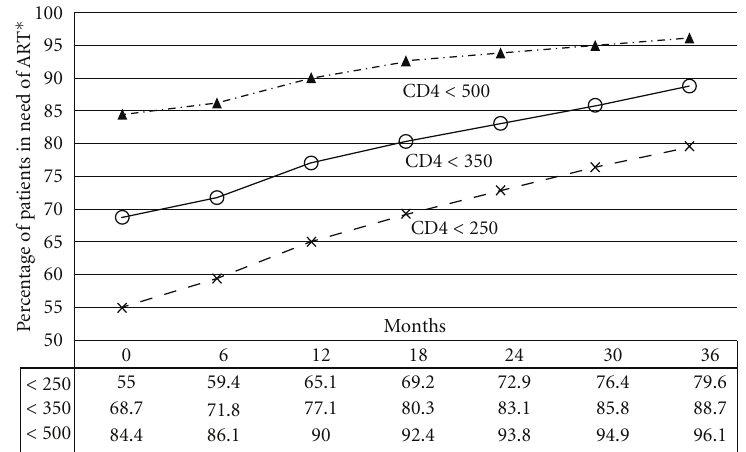
Figure 4: Cumulative incidence of patients who will require antiretroviral treatment according to three di ff erent thresholds for initiating HIV treatment after 0, 6, 12, 18, 24, 30 and 36 months since the first determination of CD4 lymphocyte count. ∗ ART: antiretroviral therapy.